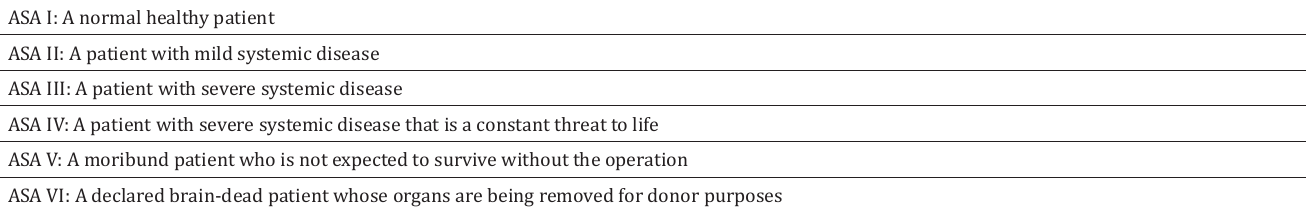
The American Society of Anesthesiologists physical status classification system